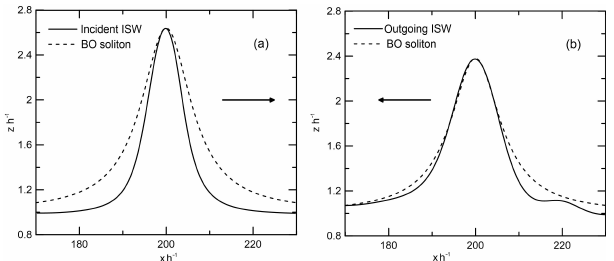
Figure 5. Wave profile of a wave before (a) and after (b) collision in section x L (b) for α = 1 . 6 (case A5; A5). These profiles are com- pared with the profile of the BO